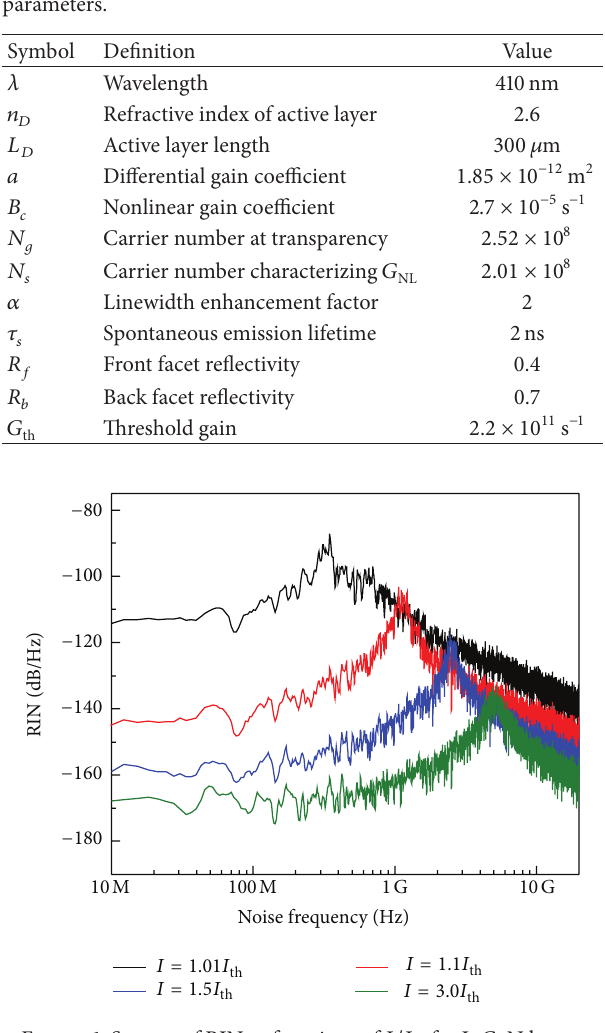
Figure 1: Spectra of RIN as functions of 𝐼/𝐼